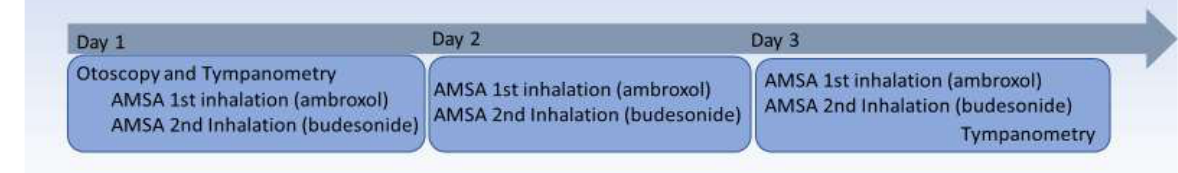
Figure 1. A diagram illustrating the setting of the AMSA protocol in this study.